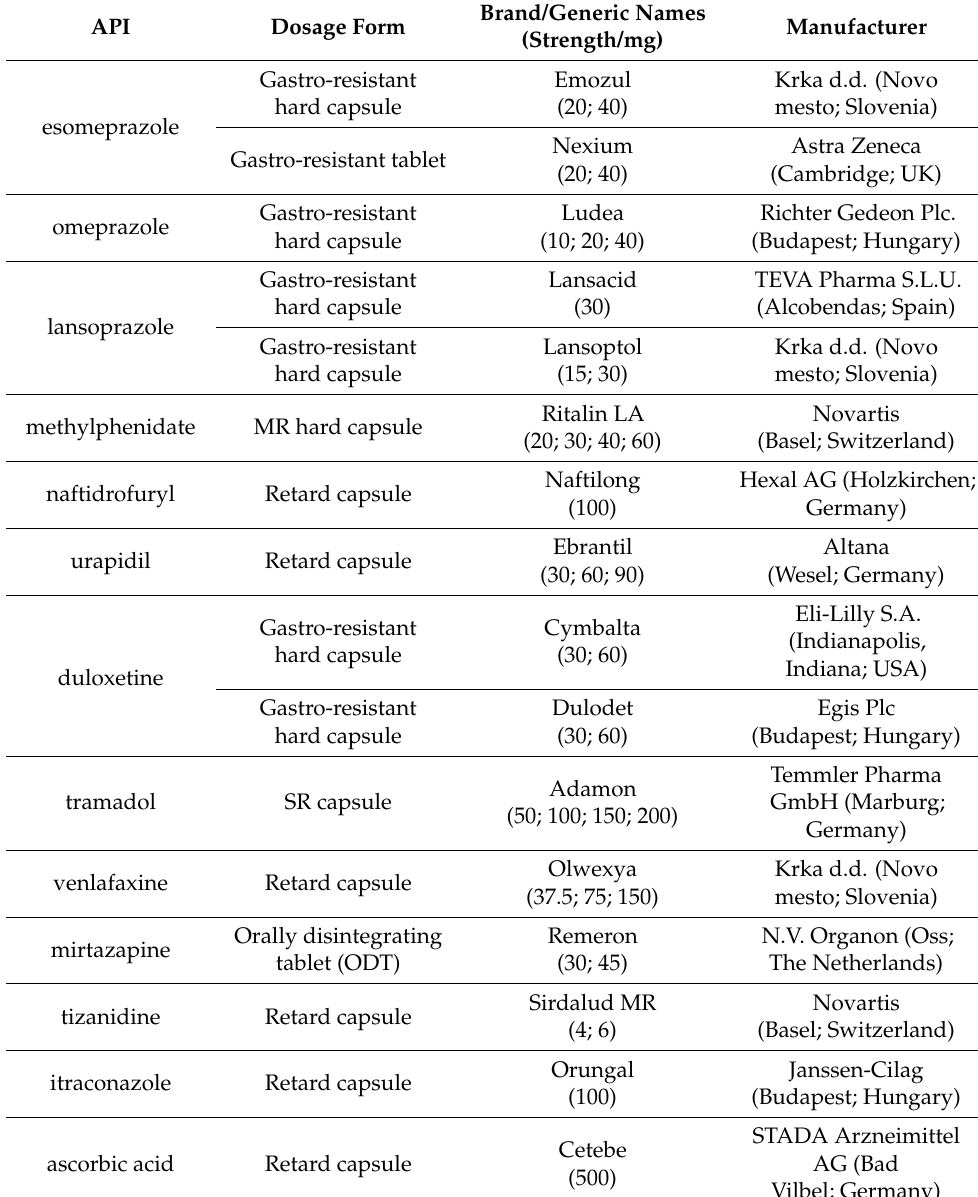
Table 4. Examples of sugar sphere-based formulations used in different dosage forms on the Hungar- ian market